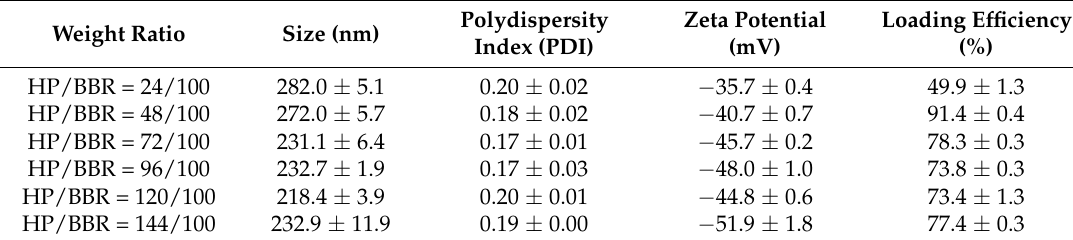
Table 1. Size, zeta potential, and loading efficiency of HP/BBR nanoparticles (NPs) ( n = 3). Weight